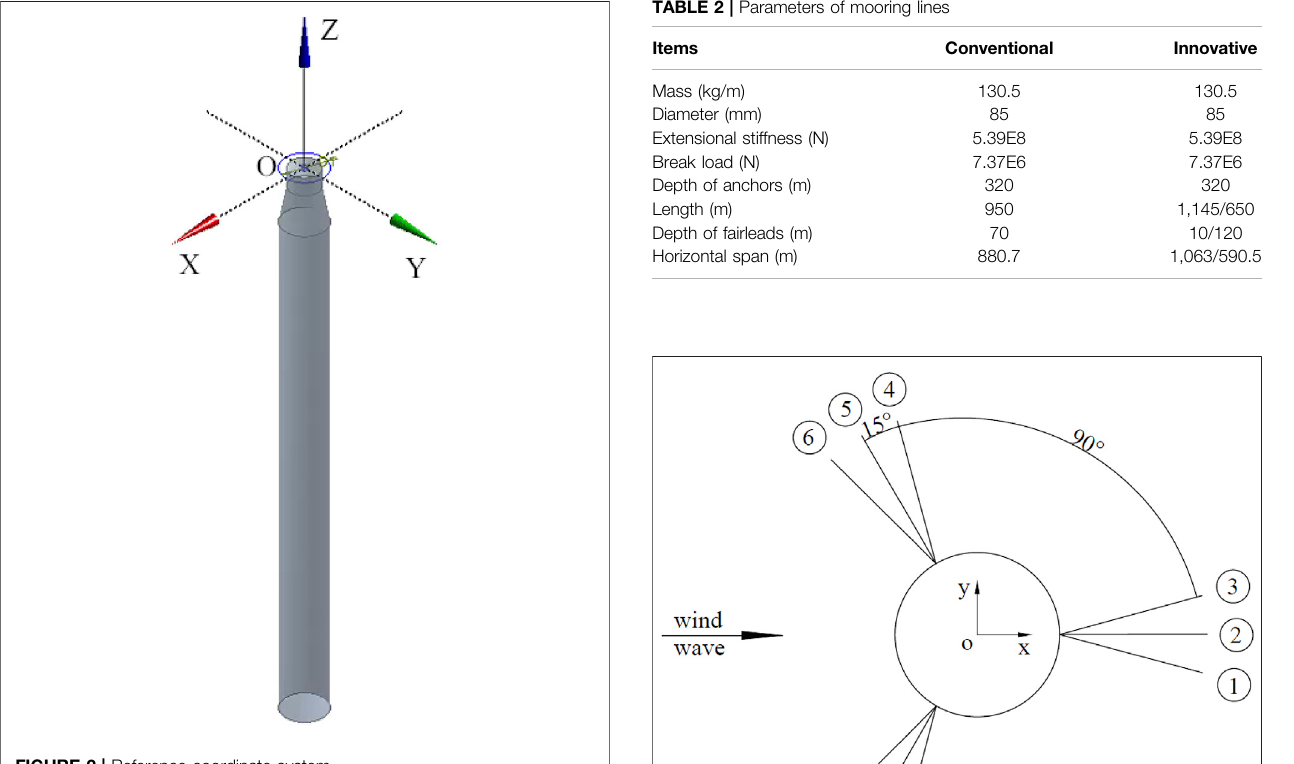
FIGURE 2 | Reference coordinate system.